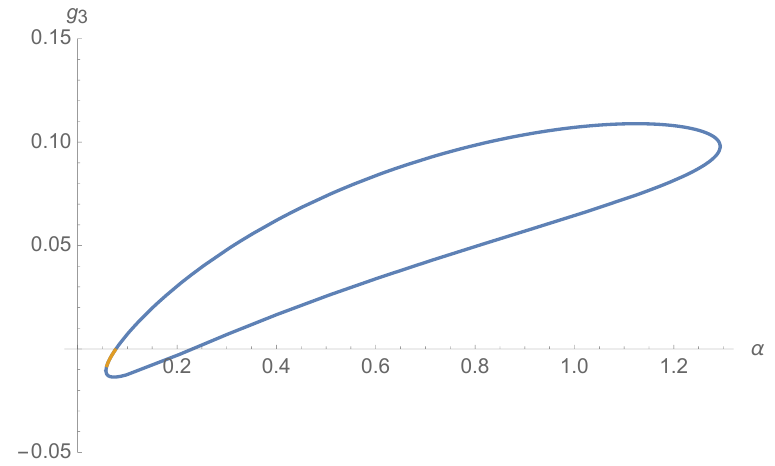
Figure 4: Critical value of g corresponds to M φ